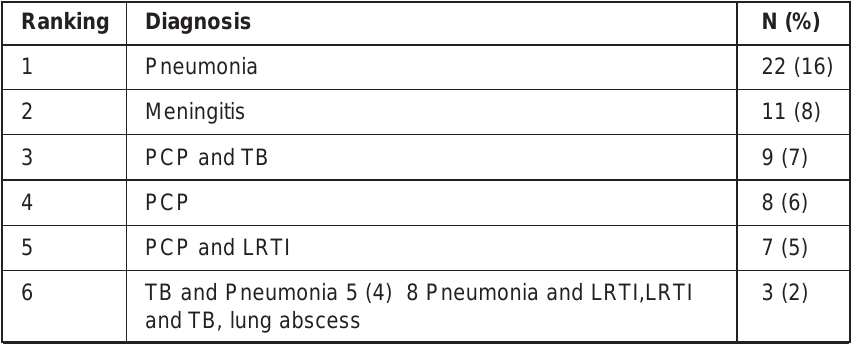
Table 4: Ranking of Diagnosis